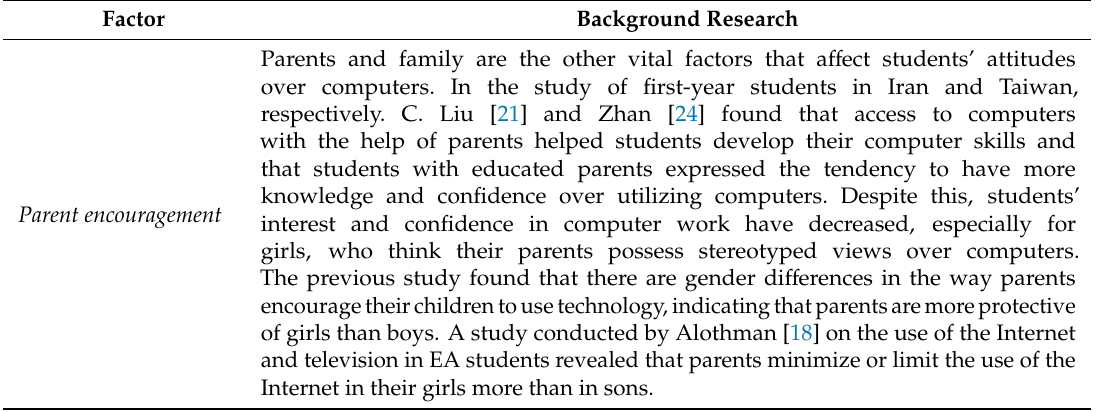
Table 1. Factors a ff ecting students’ Information and Communication Technology (ICT)